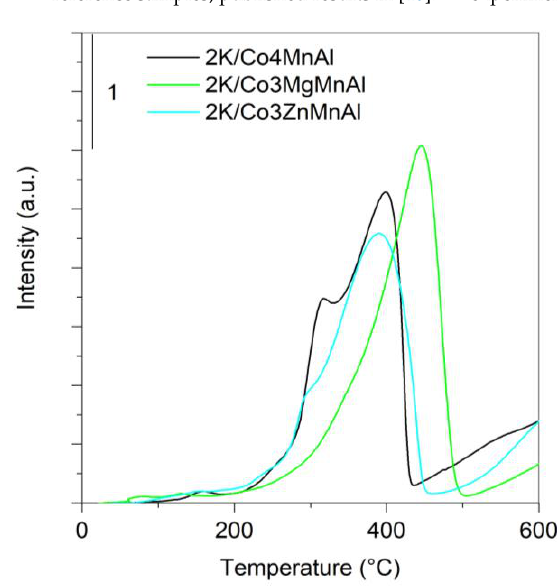
Figure 6. Temperature programmed reduction by H 2 . Table 5. Reducibility of prepared mixed oxide catalysts.